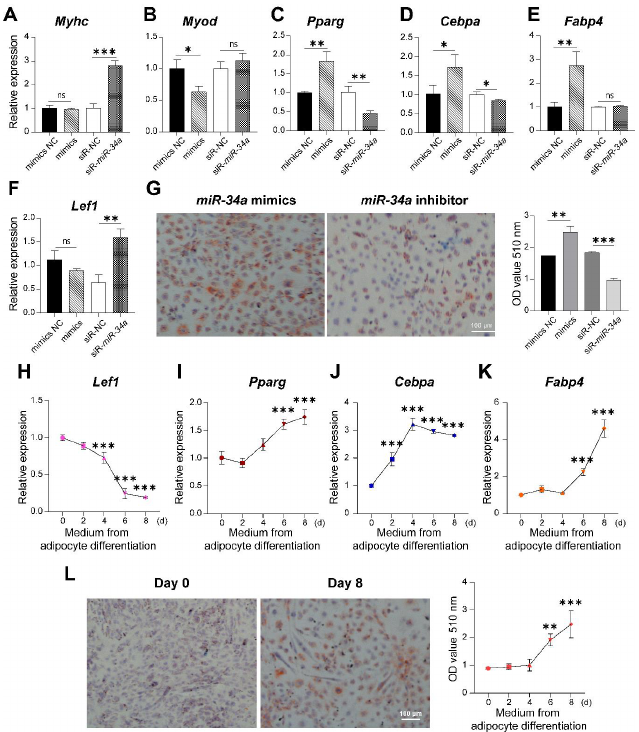
Figure 10. miR-34a / Lef1 regulated intramyocellular lipid deposition in co-culture system and C2C12 cells cultured with conditioned medium. The expression of MyHC ( A ), MyOD ( B ), Pparg ( C ), Cebpa ( D ), Fabp4 ( E ), and Lef1 ( F ), as well as Oil Red O staining[28] ( G ) in the co-culture of C2C12 and 3T3-L1 cells transfected with miR-34a mimics or inhibitor. The levels of Lef1 ( H ), Pparg ( I ), Cebpa ( J ), Fabp4 ( K ), as well as Oil Red O staining ( L ) in the C2C12 cells incubated in conditioned medium with different times of adipocyte differentiation. The magnification was 4×. The qPCR data showed the means of six independent experiments and the data of OD value (510 nm) showed the means of three independent experiments. * p < 0.05, ** p < 0.01, *** p < 0.001 versus NC.